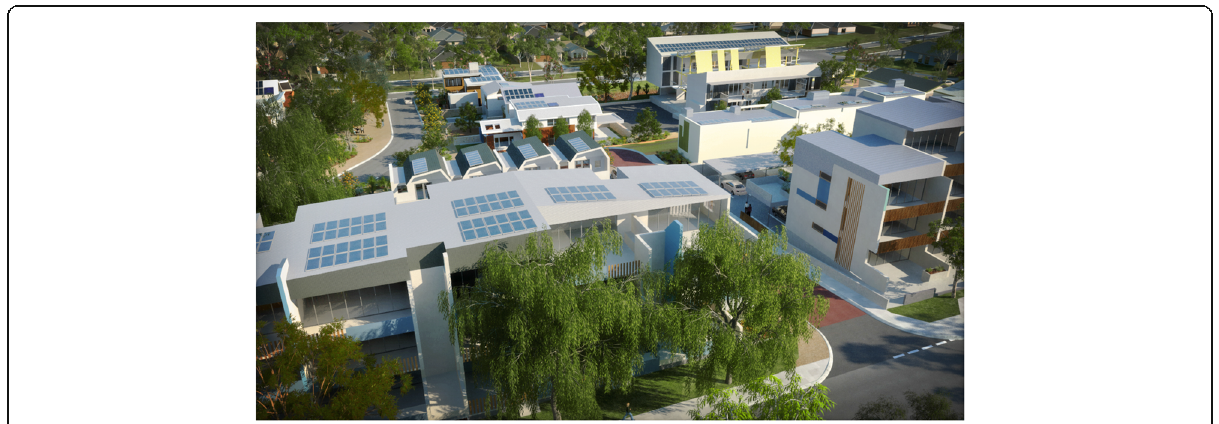
Fig. 7 WGV in Fremantle, Australia produces more solar energy than it consumes and has created new ways of sharing solar using